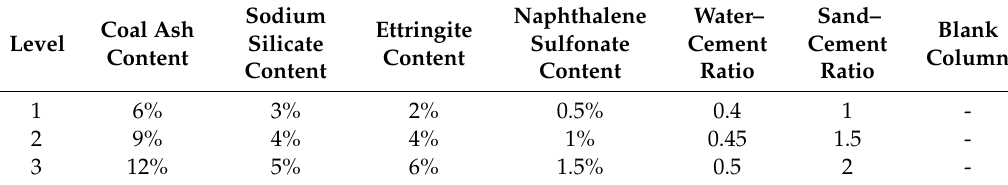
Table 3. Factors and levels of the orthogonal test.